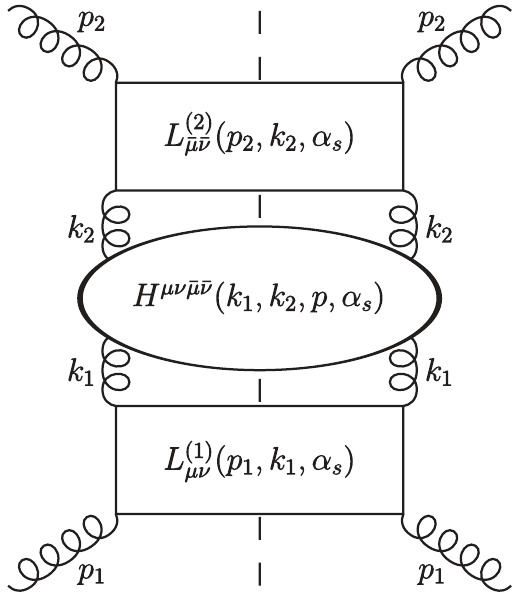
Figure 1 . High energy factorization of gluon-initiated hadro-production. (see refs. [20, 24{27] for further details). The ensuing diagrammatic structure is depicted in (cid:12)gure